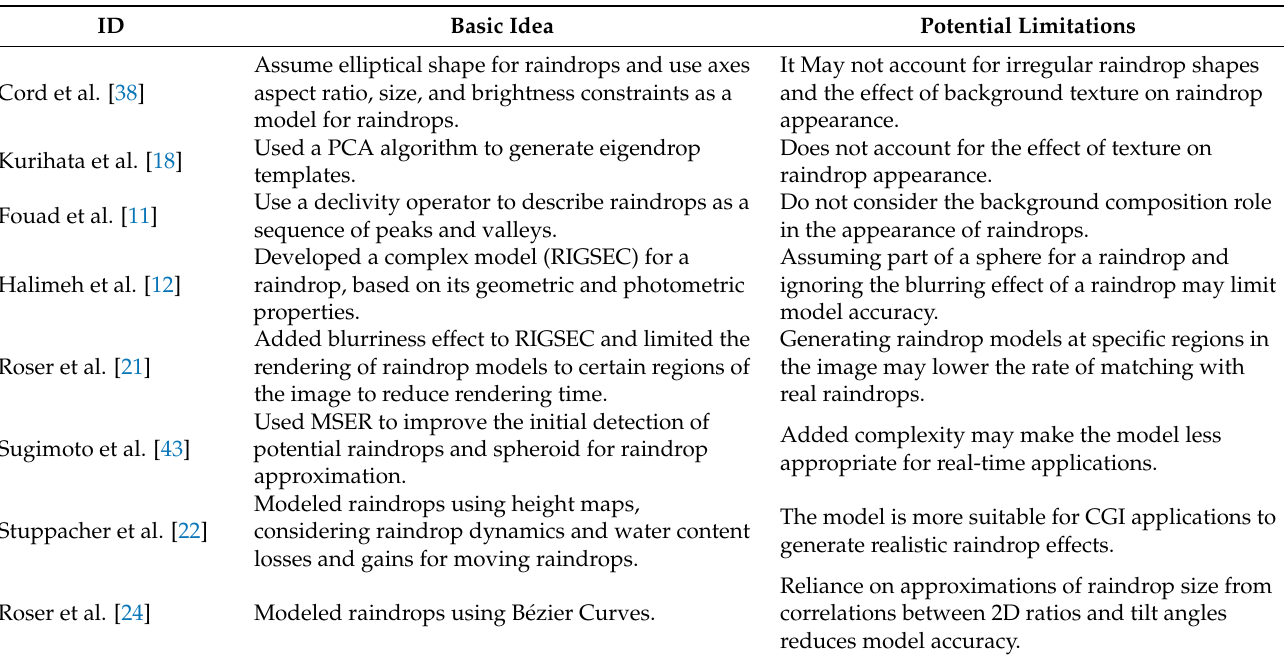
Table 3. Raindrop